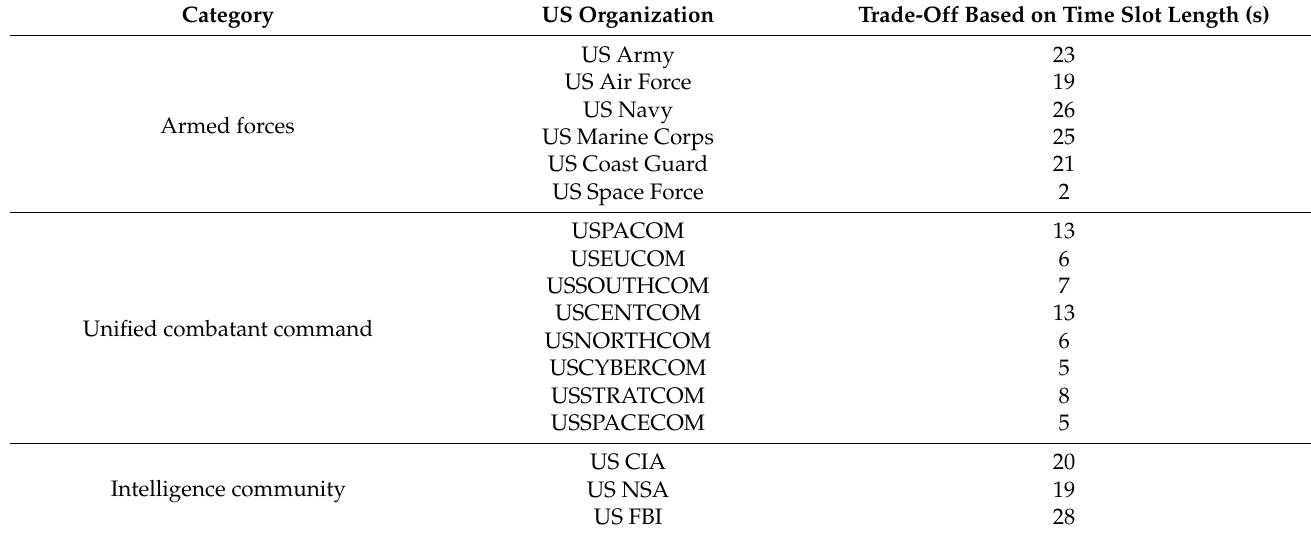
Table A6. Optimized trade-off results based on deception simulation by major US organization in Figure 9. Category